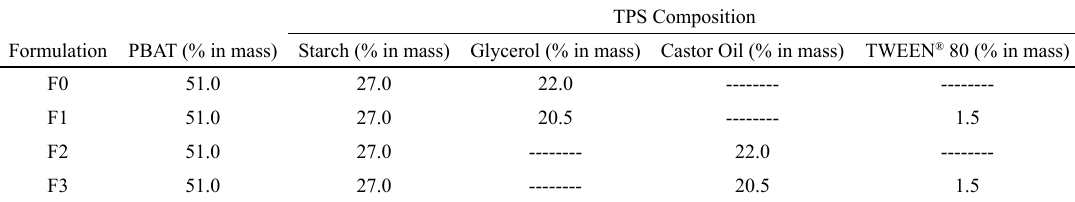
TPS Composition